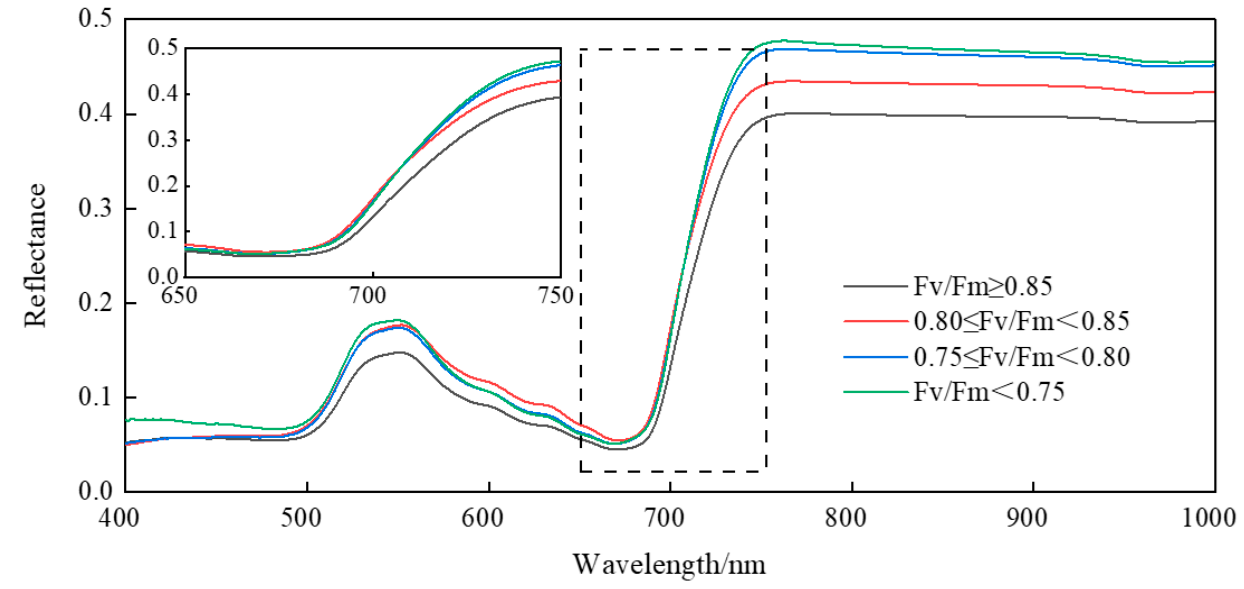
Figure 4. Original spectral reflectance at different interval Fv/Fm.